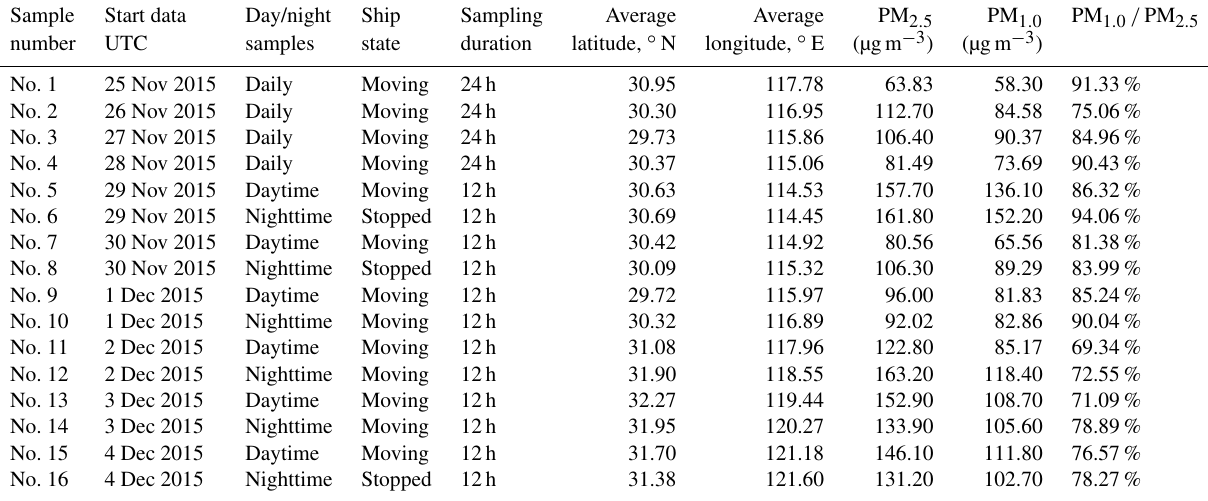
Table 1. Detailed information of ambient PM 2 . 5 and PM 1 . 0 during the YRC.